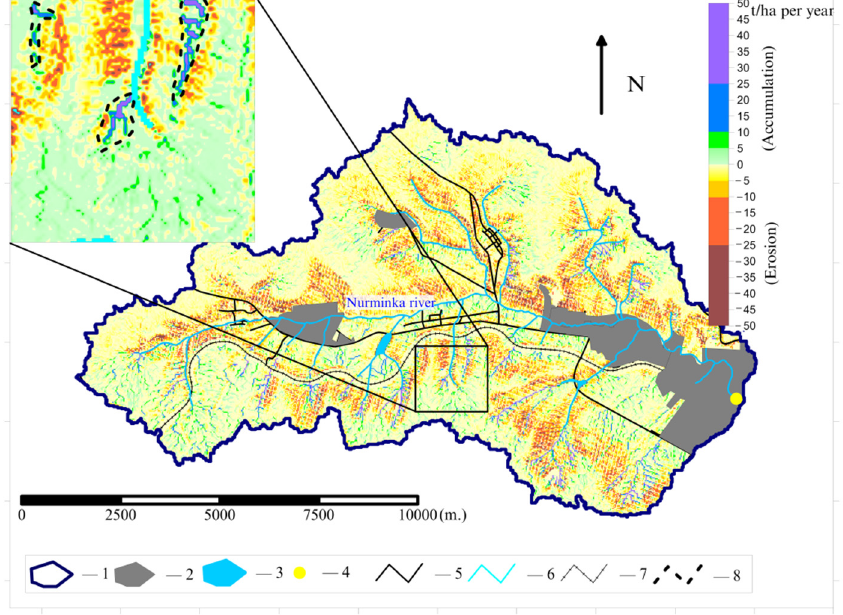
Figure 6. Map of the net water erosion obtained using SEA/Balance methodology for Nurminka river basin (Numbers: 1—river basin boundary, 2—settlements, 3—water bodies, 4—SSY observation station, 5—roads, 6—rivers, 7—railroads, 8—sediment accumulation places within dry valleys and terrace joints).